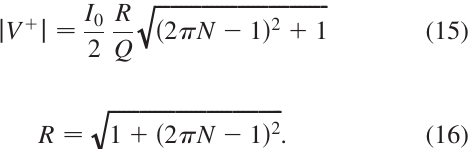
FIG. 6. By changing the parameters of a DWA, the HOMs are pushed out of the bandwidth of the drive beam so that a single mode wakefield excitation is achieved.